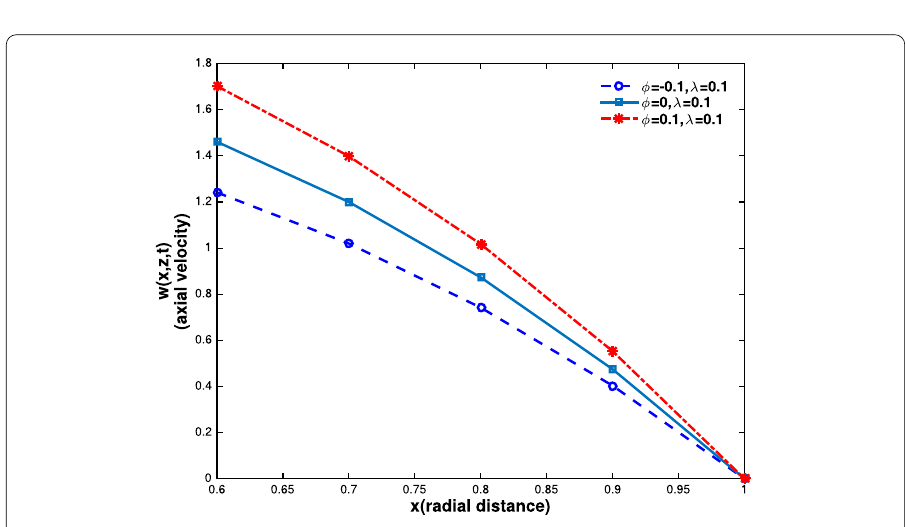
Figure 13 Axial velocity vs radial distances for φ = –0.1,0,0.1 at z = 28, t = 0.45, τ y = 0.4, K = 1.6, λ =